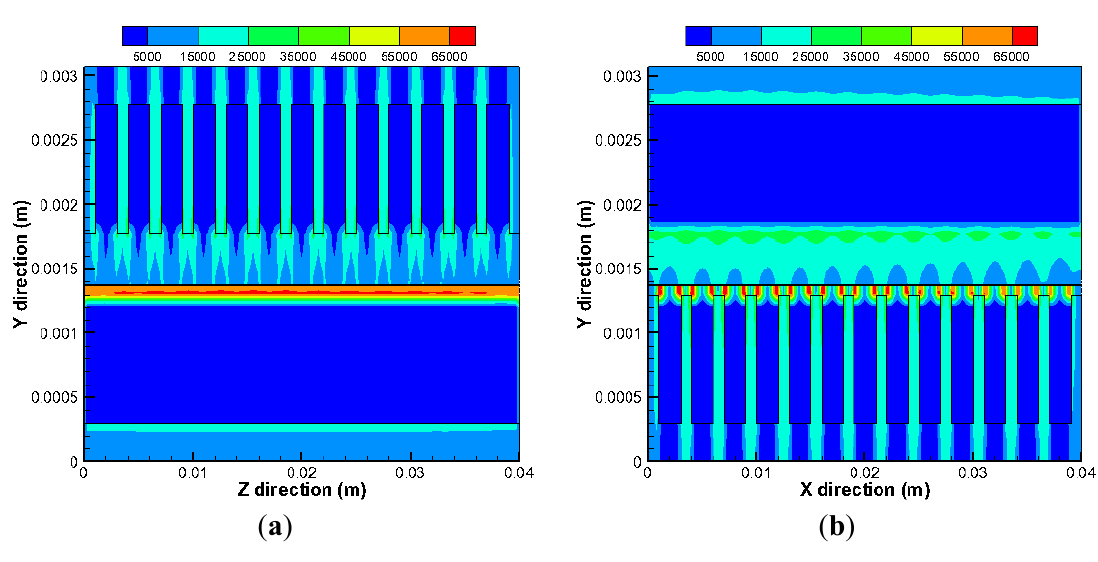
Figure 11. Current density (A/m 2 ) distribution for a cross-section in the plane for: ( a ) x = 0.03 m; ( b ) z = 0.03 m (not in